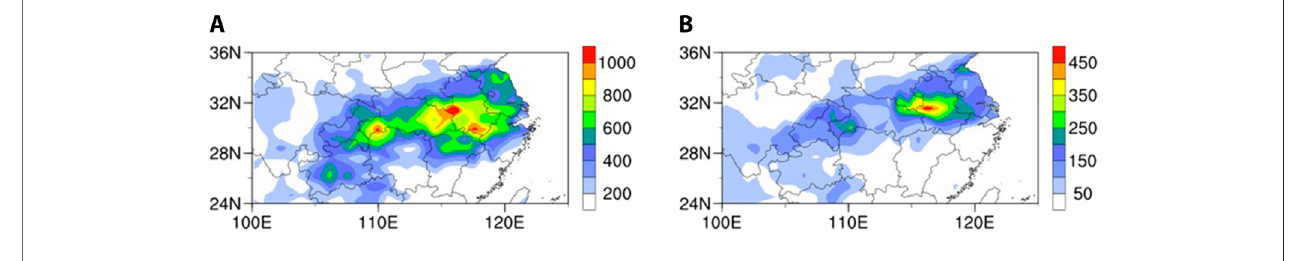
FIGURE 1 | Cumulative precipitation in the YHB (A) from June 10 to July 31 and (B) in July 11 – 19, 2020 (unit: mm).